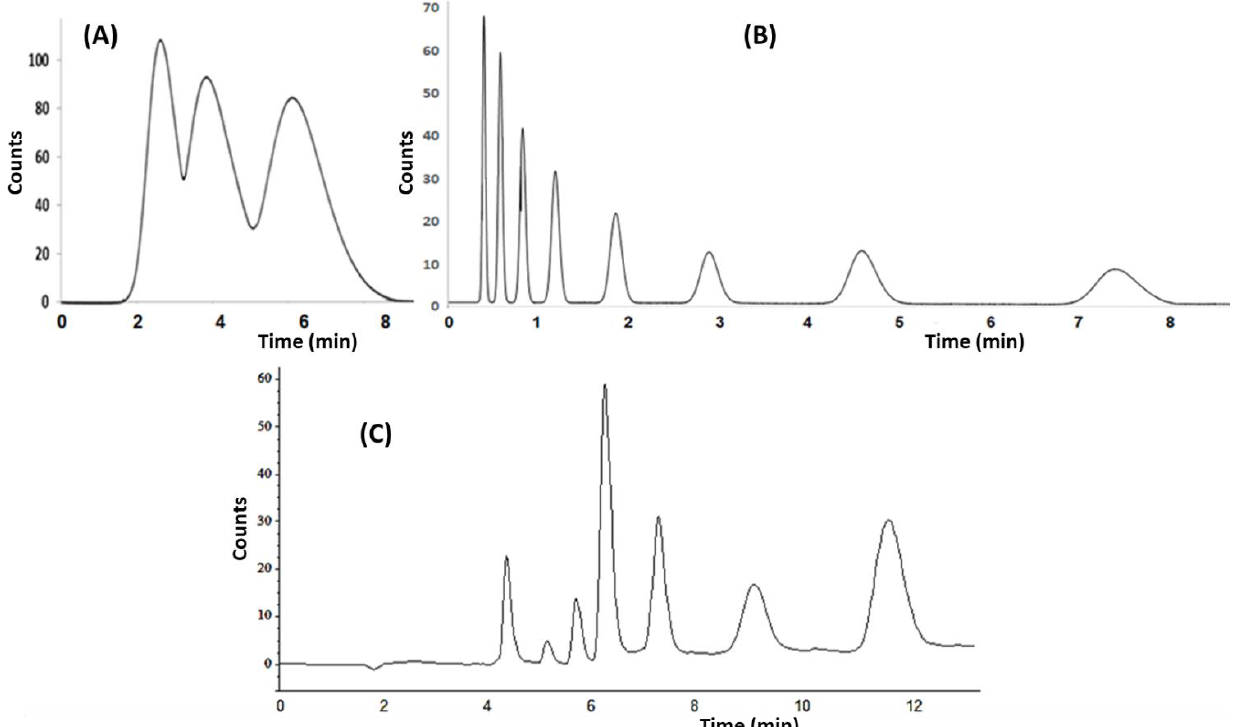
Figure 6. HPLC separation of the alkylbenzene series under the optimal conditions using GMA ( A ) and MMT@poly(GMA-co-EDMA) ( B ). Conditions: flow rate: 1.5 µL min −1 , detection wavelength: 260 nm, mobile phase: ACN/H 2 O (50:50, v / v ), column temperature: 30 °C. Compounds in order of elution: benzene, toluene, ethylbenzene, propylbenzene, butylbenzene, pentylbenzene, hexylbenzene, and heptylbenzene (10 μg mL −1 for each compound). HPLC separation of PAH mixture under the optimal conditions using MMT@poly(GMA-co-EDMA) ( C ). Conditions: flow rate: 0.5 μL min −1 , detection wavelength: 230 nm, mobile phase: 0 → 3 min; 40% acetonitrile, 3 → 13 min; linear gradient 40% → 90% acetonitrile, column temperature: 50 °C. Compounds in order of elution: naphthalene, acenaphthylene, phenanthrene, anthracene, pyrene, chrysene, and dibenzo( a , h )anthracene (10 μg mL −1 for each compound).